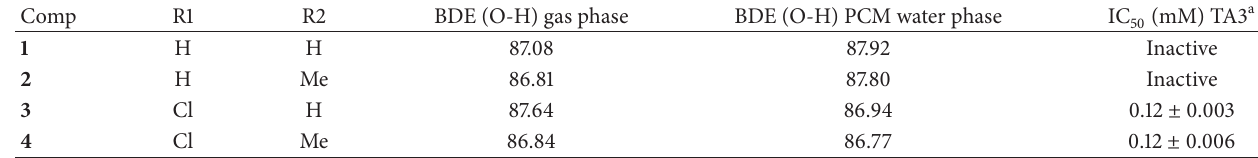
Table 1: Bond dissociation energies (kcal/mol) for compounds 1 – 4 in gas phase and water solvated (PCM) phase.